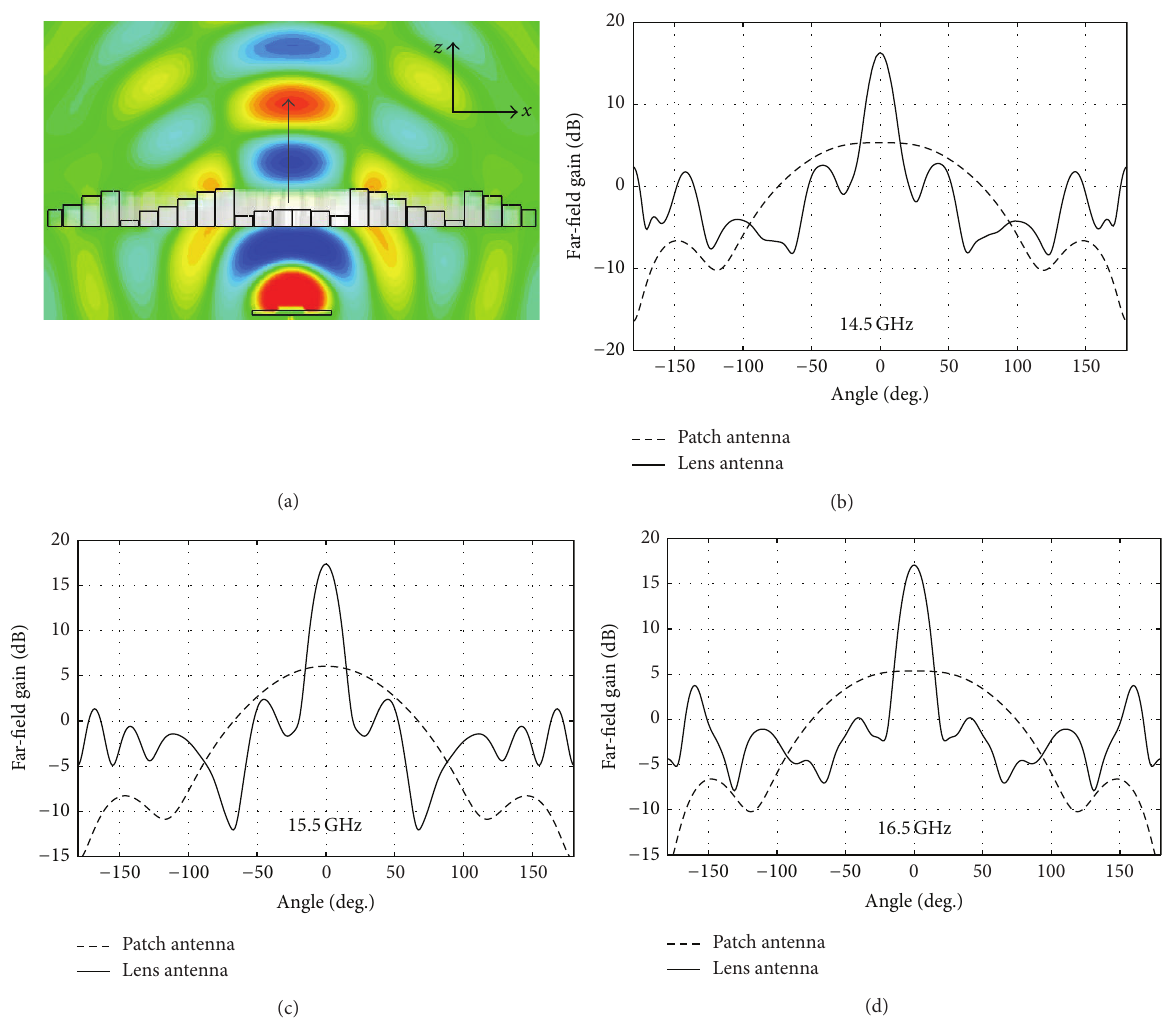
Figure 6: The simulated results of the dielectric metasurface-based lens antenna system. (a) Comparison of 𝐸 -plane far-field radiation pattern of the lens antenna (solid line) and the patch antenna itself (dashed line) at 14.5 GHz, (b) at 15.5 GHz, and (c) at 16.5